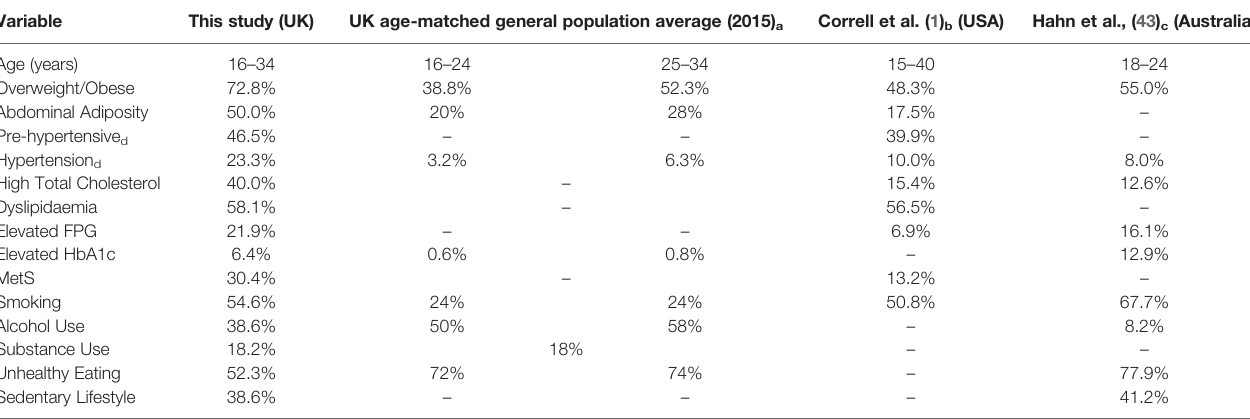
TABLE 4 | Comparison of cardiometabolic risk factor prevalence to age-matched